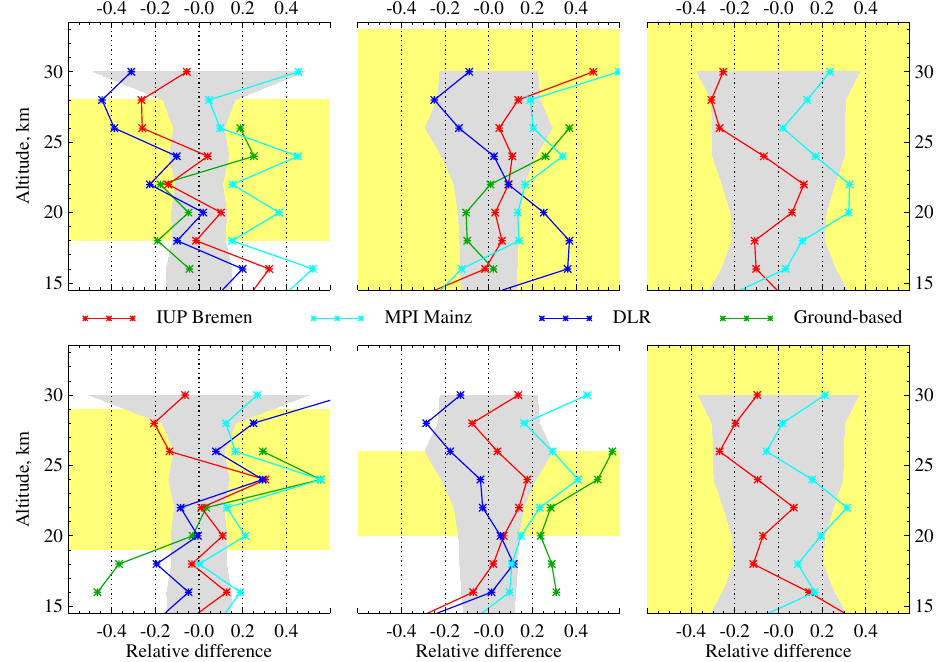
Fig. 22. Same as in Fig. 21 but for relative differences with respect to balloon-borne DOAS results, e.g., IUP Bremen/DOAS-1, etc.